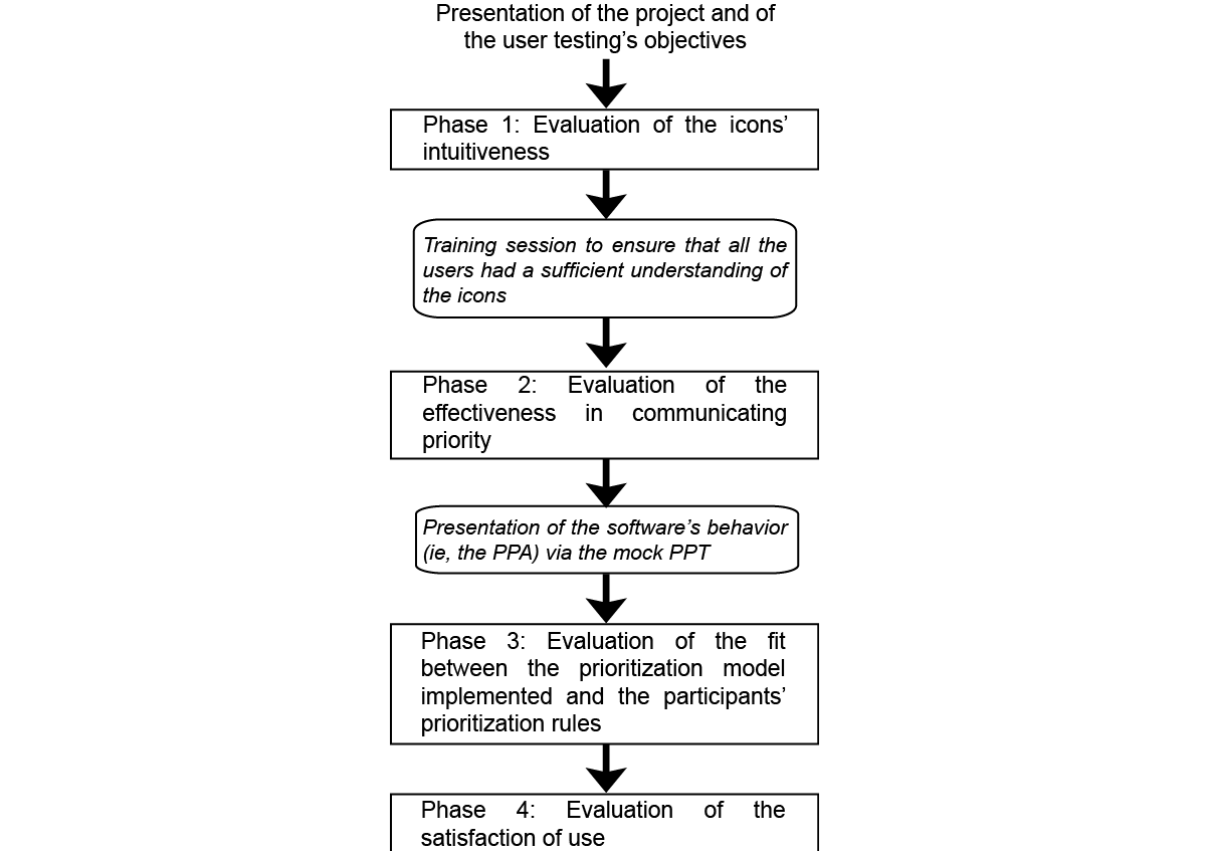
Figure 2. Rollout of the user testing. Testing sessions are presented in the straight-lined boxes and training sessions are presented in italic font. PPA: patient prioritization algorithm; PPT: patient prioritization